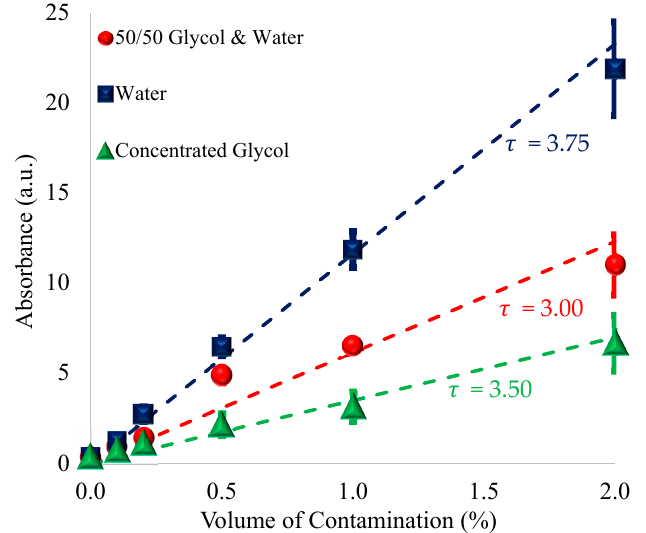
Figure 2. Average areas of absorbance of the 3400 cm − 1 O–H peak due to contamination vs. percent concentration after emulsifying by direct probe sonication. The dashed lines represent predicted values of O–H concentration normalized to glycol as given by the normalizing constant 𝜏 , as shown on the chart, and are plotted as (O–H/vol) ∗𝜏 vs. percent contamination, where the O–H per unit volume is normalized to glycol.